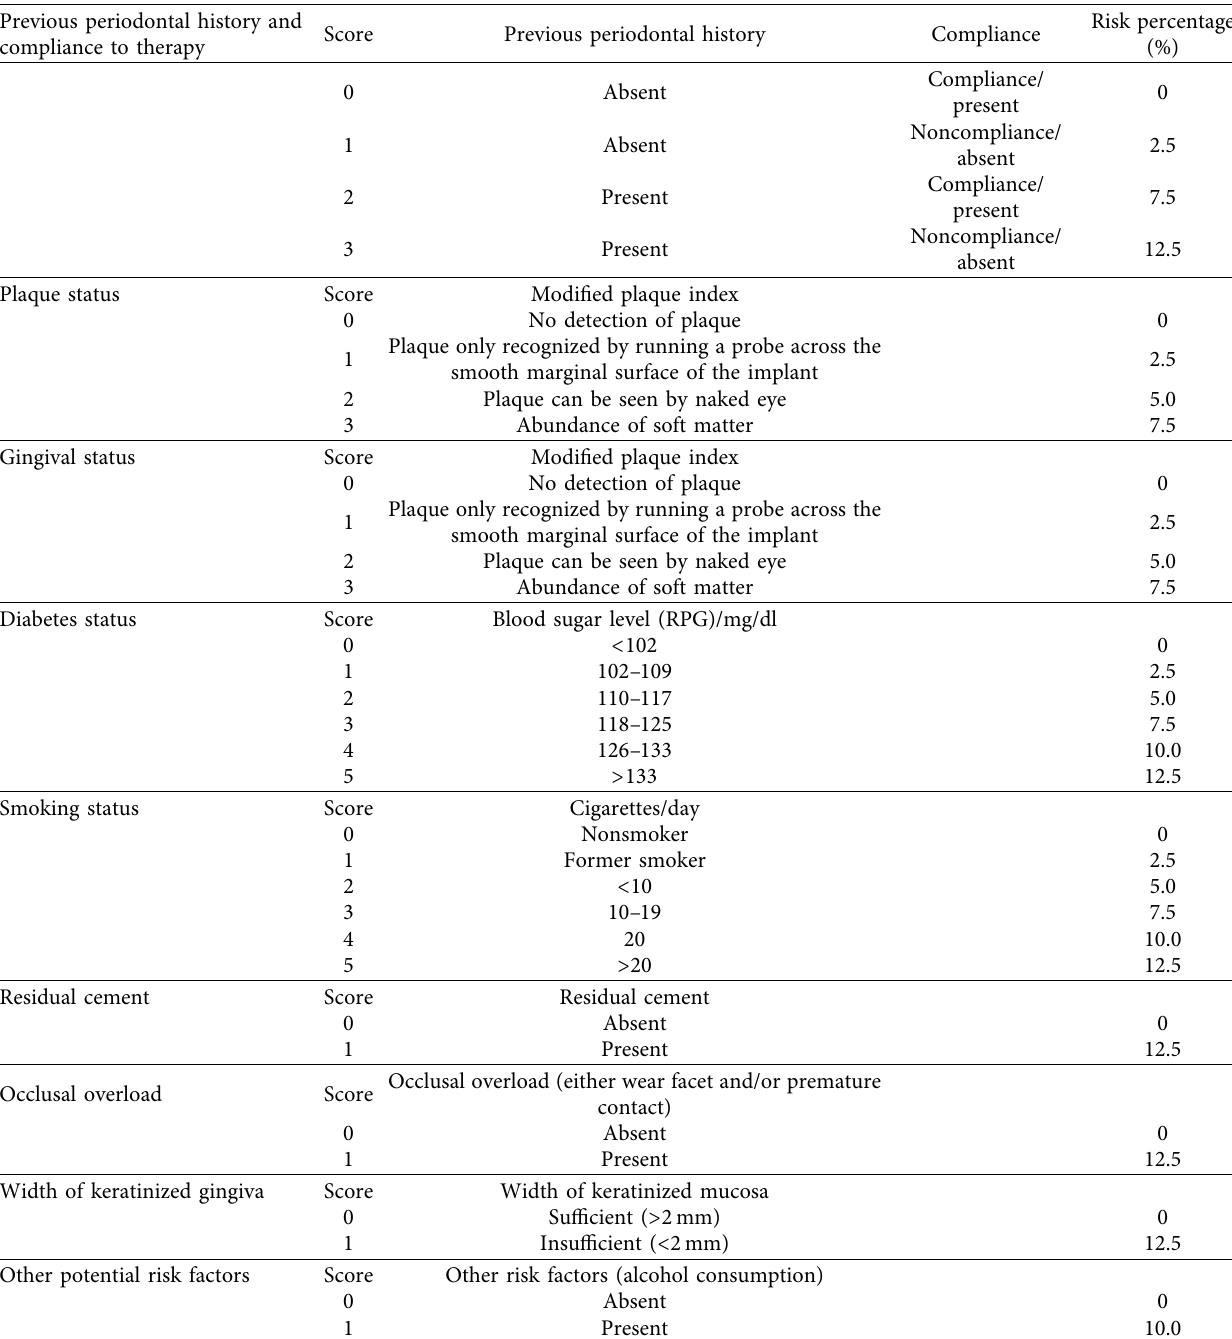
Table 2: New risk assessment